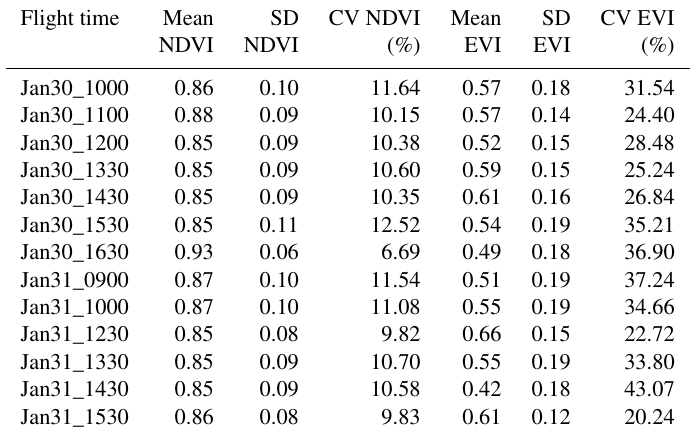
Table A2. Mean, standard deviation (SD), and coefficient of variation (CV) of NDVI and EVI measurements for the